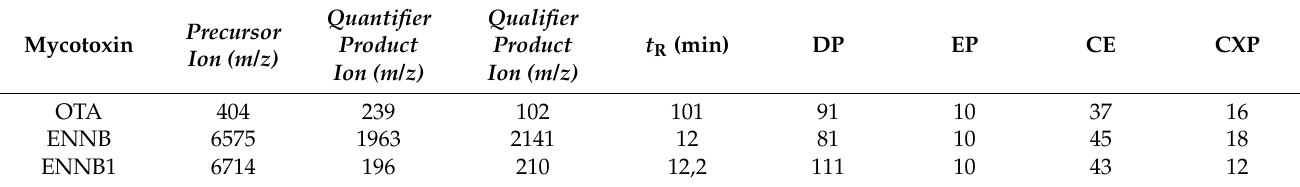
Table 2. Optimized mass spectrometry UHPLC-MS/MS parameters for the determination of Ochra- toxin A, Enniatin B, and Enniatin B1.